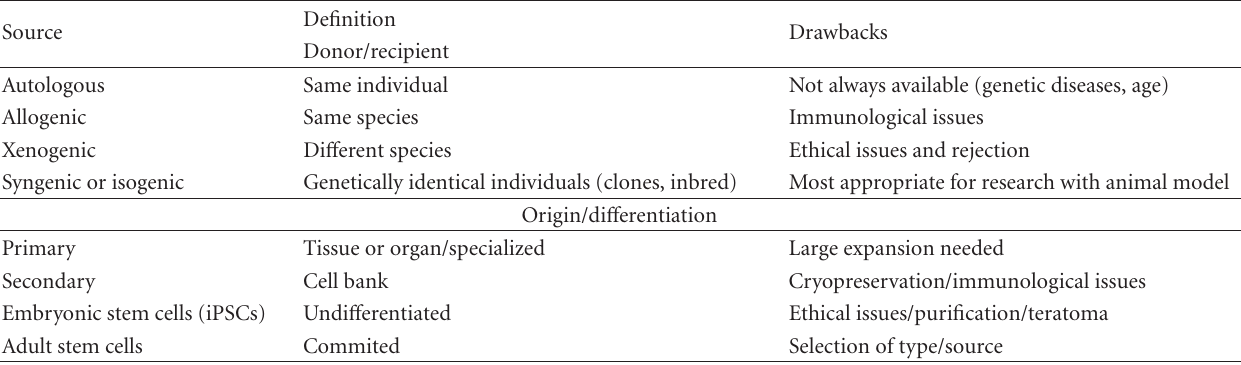
Table 1: Potential cell source.